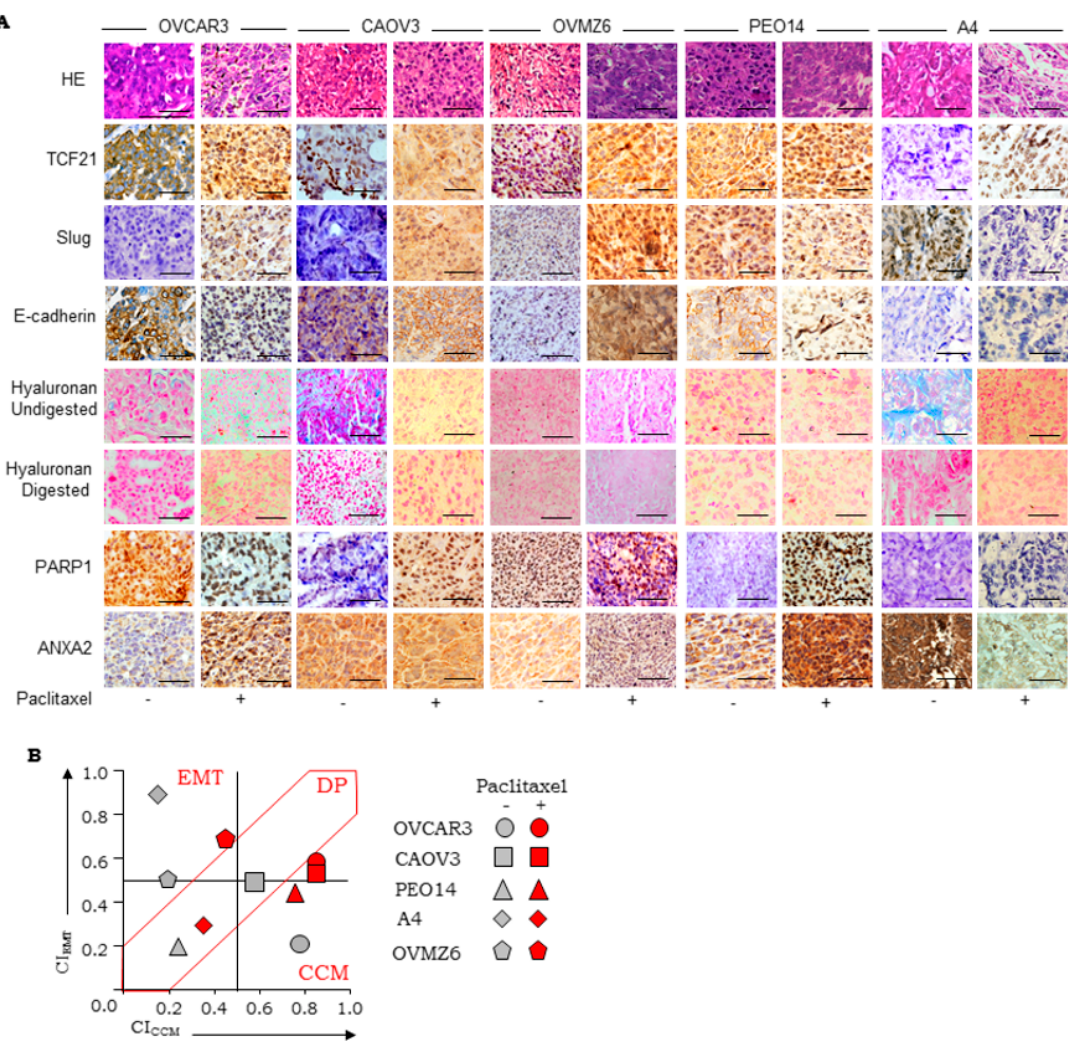
Figure 5. ( A ). Paclitaxel exposure alters scoring marker panel in HGSC cell line derived xenografts. Representative images of HGSC xenograft (control and paclitaxel treated) sections for Row 1-HE (hematoxylin and eosin), Rows 2,3,4,7,8 represent IHC-based detection of TCF21, Slug, E cadherin, PARP1, and ANXA2, Rows 5 and 6 represent HC-based identification of HA fibers in untreated and hyaluronidase digested sections respectively, scale bars-50 µ m; ( B ) scatter plots of CI CCM vs. CI EMT derived from xenograft (control-grey and paclitaxel treated-red) scoring. EMT-epithelial to mesenchymal transition; DP-double positive; CCM-cooperative cell migration.